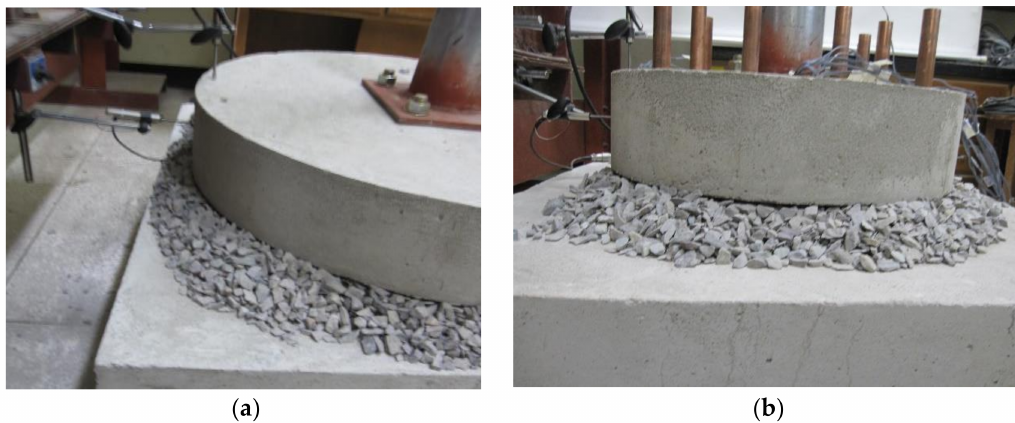
Figure 8. Overturning of wind turbine foundation: ( a ) overturning (existing type); ( b ) overturning of wind turbine foundation reinforced with